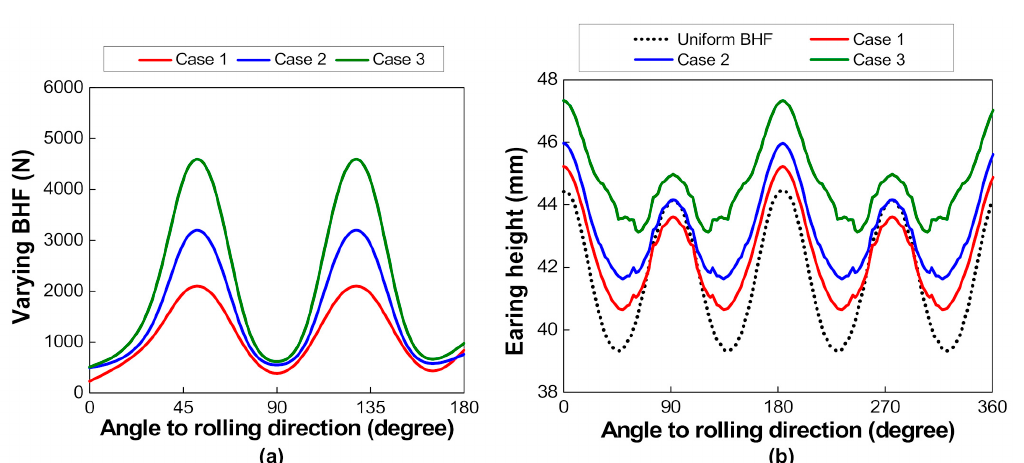
Figure 12. Results of ( a ) BHF variation and ( b ) earing height profiles of AA1050-O by using three cases of varying BHF with α , β , γ selected from the full factorial design: Case 1 ( α = 1500, β = – 650, γ = 820); Case 2 ( α = 2900, β = – 250, γ = 720); Case 3 ( α = 4300, β = – 450, γ = 920).